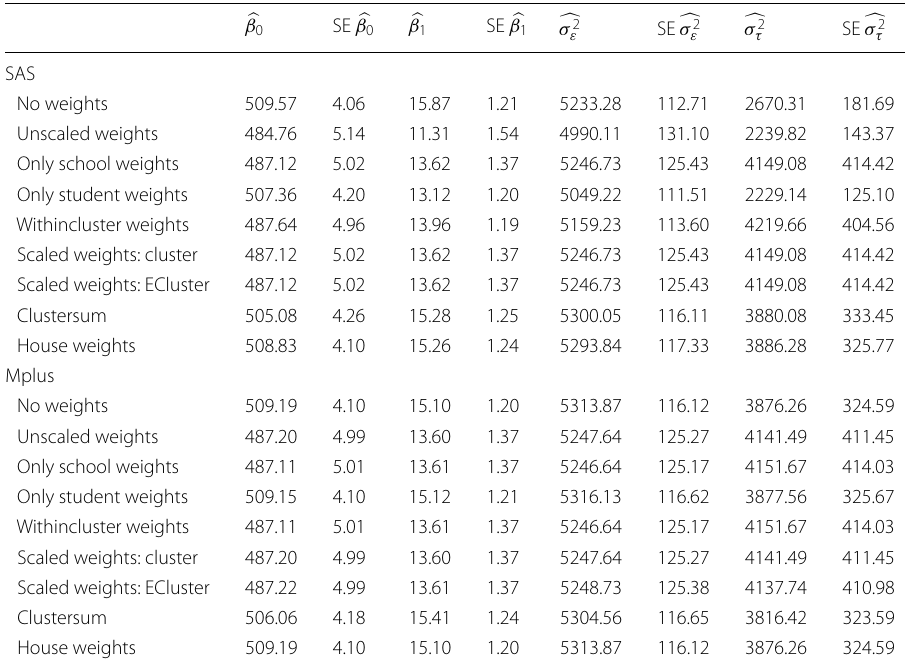
Classifying the results of the simulation study to application data, the different weighting approaches combined with different estimation algorithms implemented in the two examined software packages are